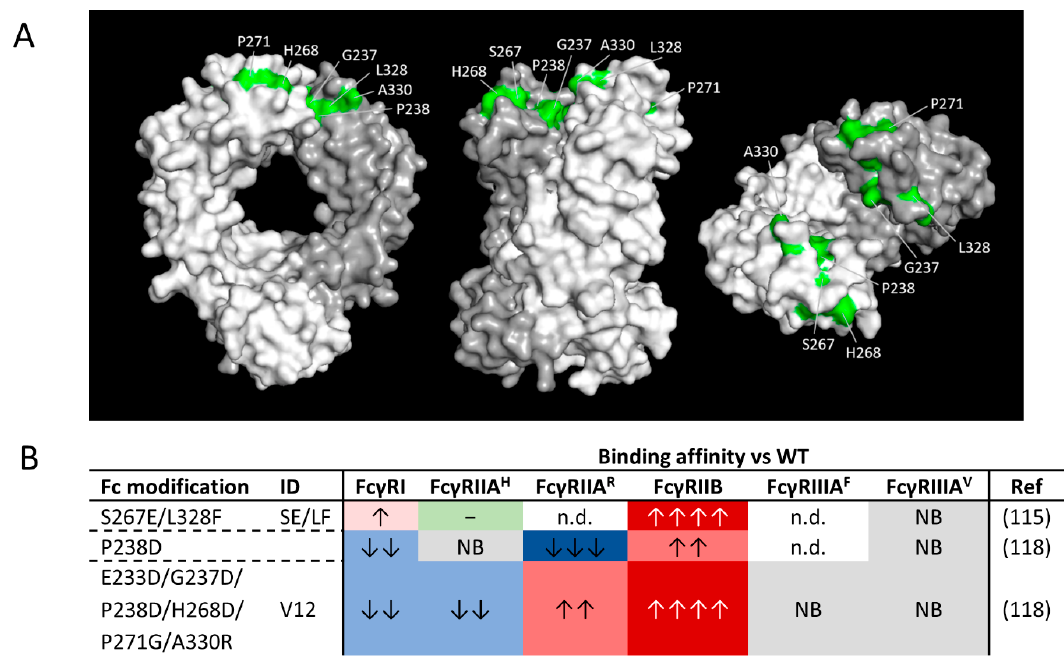
Figure 3. Fc modifications which enhance binding to Fc γ RIIB. ( A ) Previously identified point mutations within the Fc that impact binding to Fc γ RIIB annotated on a hIgG1 Fc crystal structure model (PDB: 3AVE; [49,50]). ( B ) Magnitude of binding affinity of variants were compared to WT antibodies of the same IgG isotype and F(ab) region. Each row depicts an independent experiment and therefore often independent methods, utilizing a different IgG backbone from a particular study as referenced in the last column. NB = no detectable binding, n.d. = no data, − = no change, ↑ < 2 fold upregulation, ↑↑ 2–9.99 fold upregulation, ↑↑↑↑ > 100 fold upregulation, ↓↓ 2–9.99 fold downregulation, ↓↓↓ 10–99.99 fold downregulation, Fc γ RIIA H Fc γ RIIA-H131, Fc γ RIIA R Fc γ RIIA-R131, Fc γ RIIIA F Fc γ